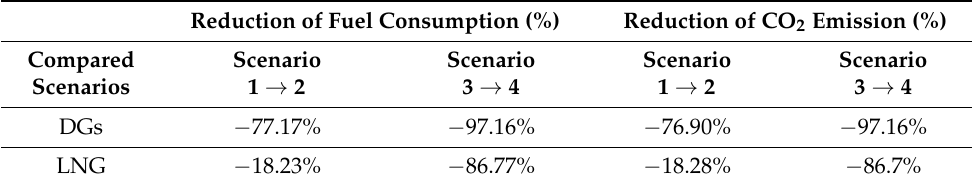
Table 9. Reduction of Fuel Consumption and CO 2 Emissions